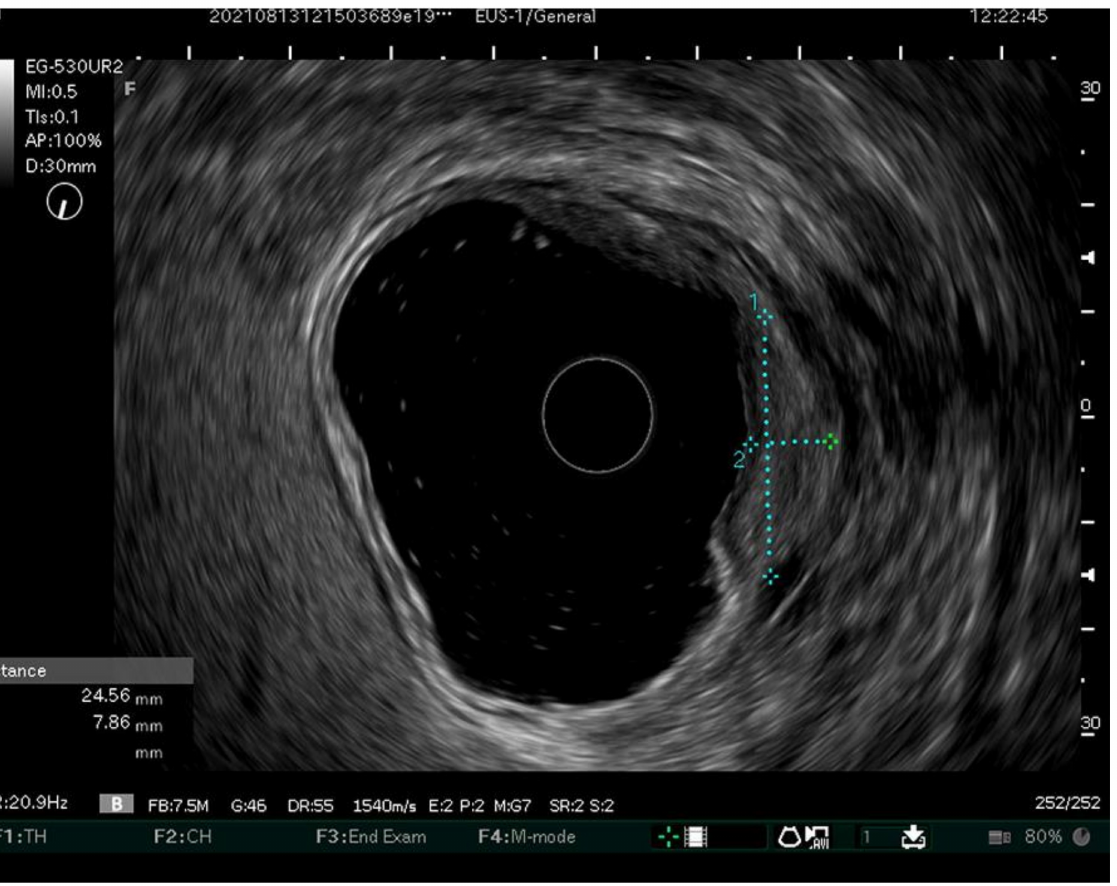
Figure 2. EUS image of a gastric lesion 24.5 × 7.8 mm in size. The endoscopy result was low-confident for SM invasion. EUS was suggestive of SM1 invasion only. After ESD, SM1 invasion was